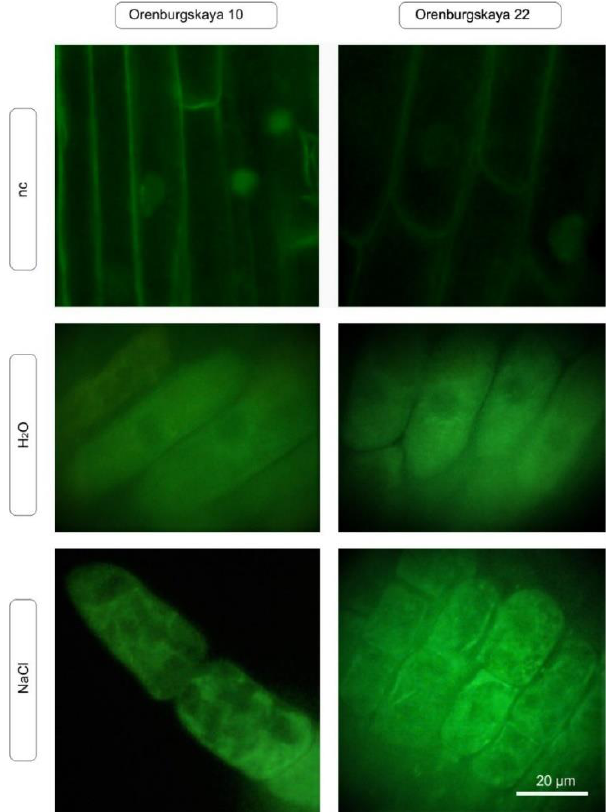
Figure 6. In vivo detection of mitochondria using MitoTracker Green FM (green) in 10-day-old wheat root cells under normal plant cultivation conditions and in the presence of NaCl (nc: negative control).